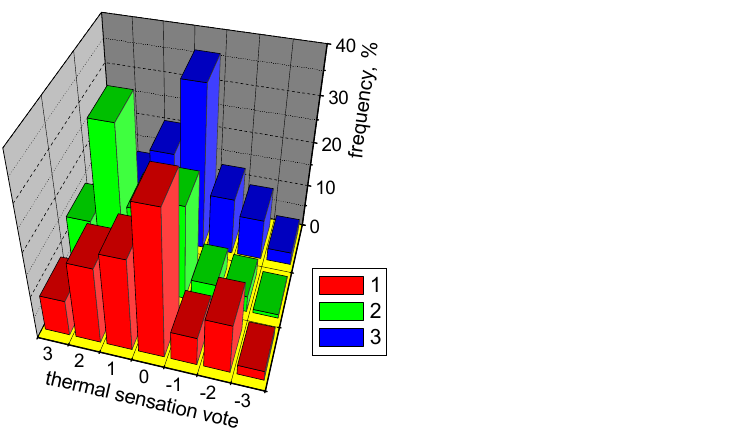
Figure 5. Distribution of thermal sensation votes in the Courthouse (1), “A” building (2) and “Energies” (3).